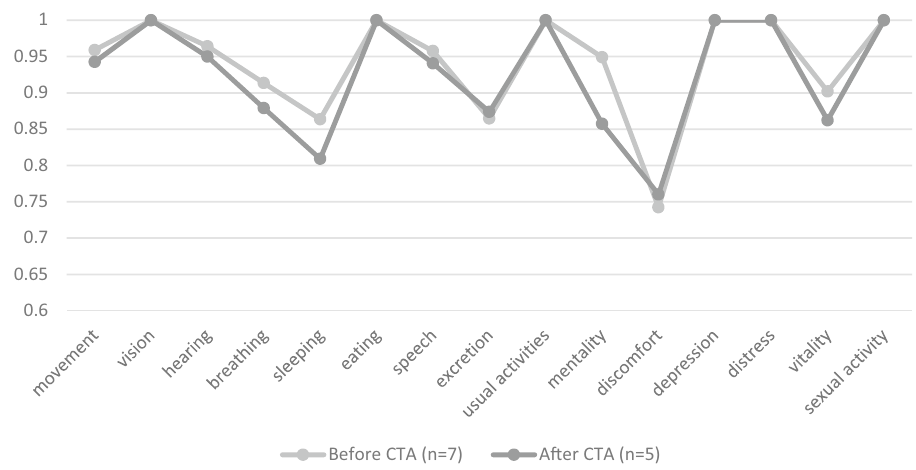
Figure 5. Health-related quality of life dimensions (15D score) of the participants prior to and after CTA with any findings (UIA, UIA suspicion or DAVF).